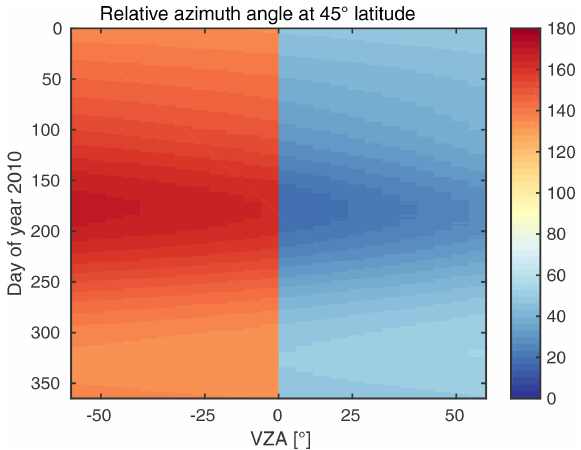
Figure 6. Same as Fig. 5 but showing the RAA at 45 ◦ N latitude.